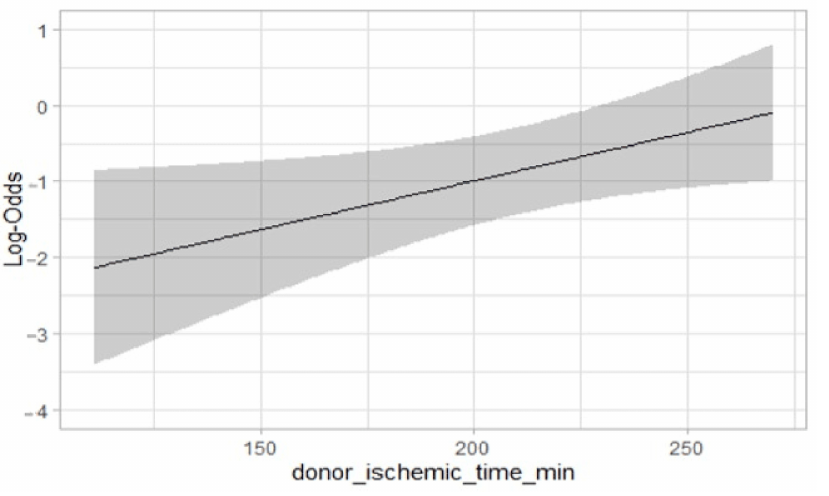
Figure 2. Graphical representation of linear and significant association between cold ischemic time in MDs and primary graft failure onset. (Logistic regression